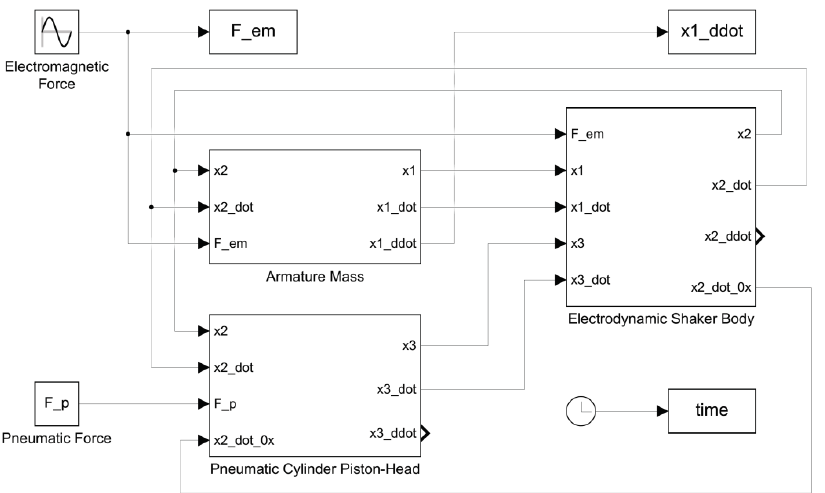
Figure A1. The Simulink model of the present work. Equations (1) – (11) are modelled using blocks and wires in Simulink, and they are grouped into three subsystems, namely, armature mass, electro- dynamic shaker body and pneumatic cylinder piston head, in the model to show the input, output and variable of each subsystem in the experimental system of the present work while reducing the complexity of the model for the ease of signal probing. Three source blocks are used to generate the step and sinusoidal input signals, as well as the time signals, for the model. The generated sinusoidal input, time and response signals are deposited to three sink blocks for post-processing in